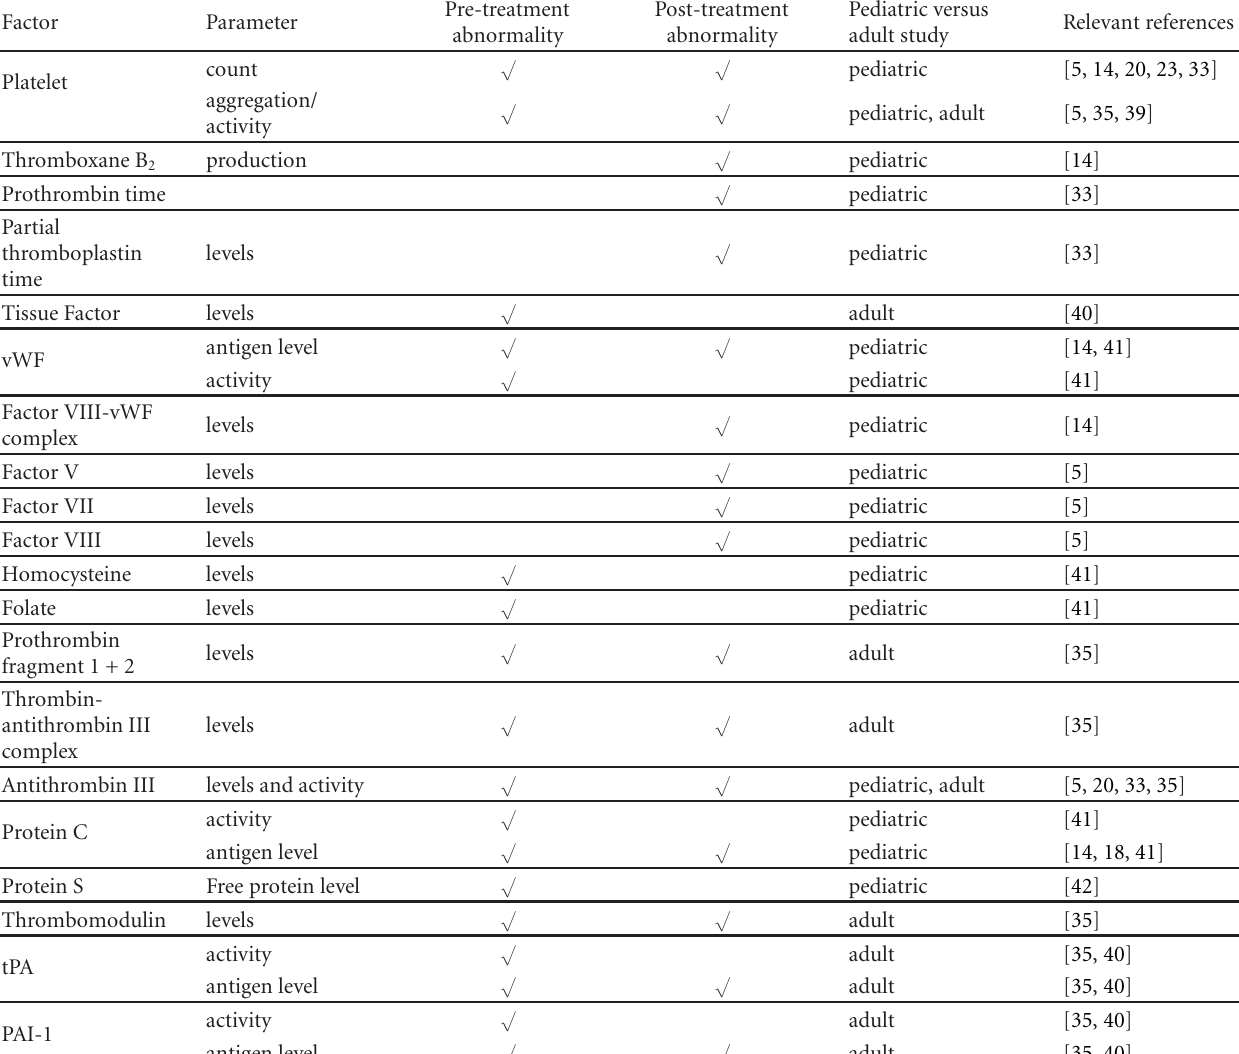
Table 2: Coagulation abnormalities noted in cases of pediatric DKA with stroke and in studies of DKA-associated coagulopathy in adults and children. Pretreatment abnormalities include those noted prior to resolution of biochemical abnormalities. Posttreatment abnormalities include those noted after resolution of biochemical